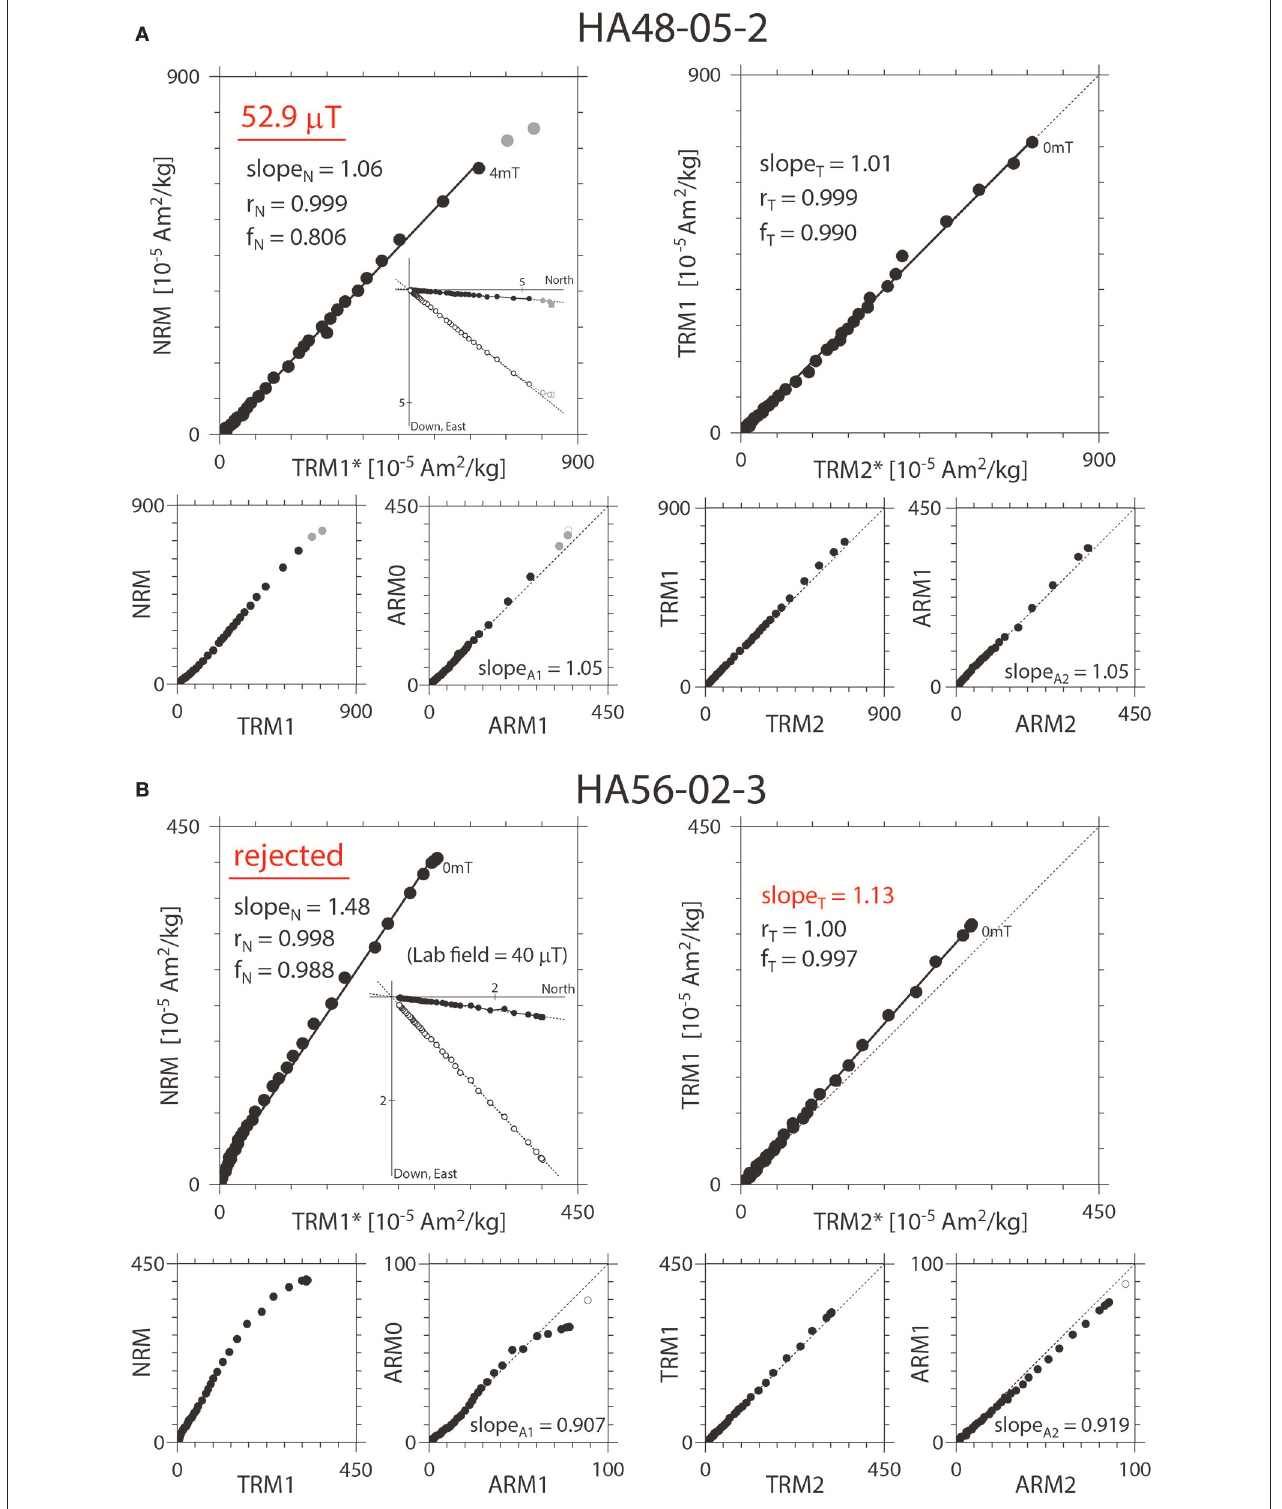
FIGURE 4 | Representative results of the Tsunakawa–Shaw paleointensity experiments. (A) A successful result from site HA48; (B) A rejected result from site HA56. The diagrams shown on the left-hand (right-hand) side are results from the first (second) laboratory heating, where closed symbols indicate coercivity intervals for the linear segments. AF demagnetization results on NRM are also shown as insets of orthogonal vector-end-point diagrams, where closed (open) symbols indicate projections onto horizontal (vertical) planes.